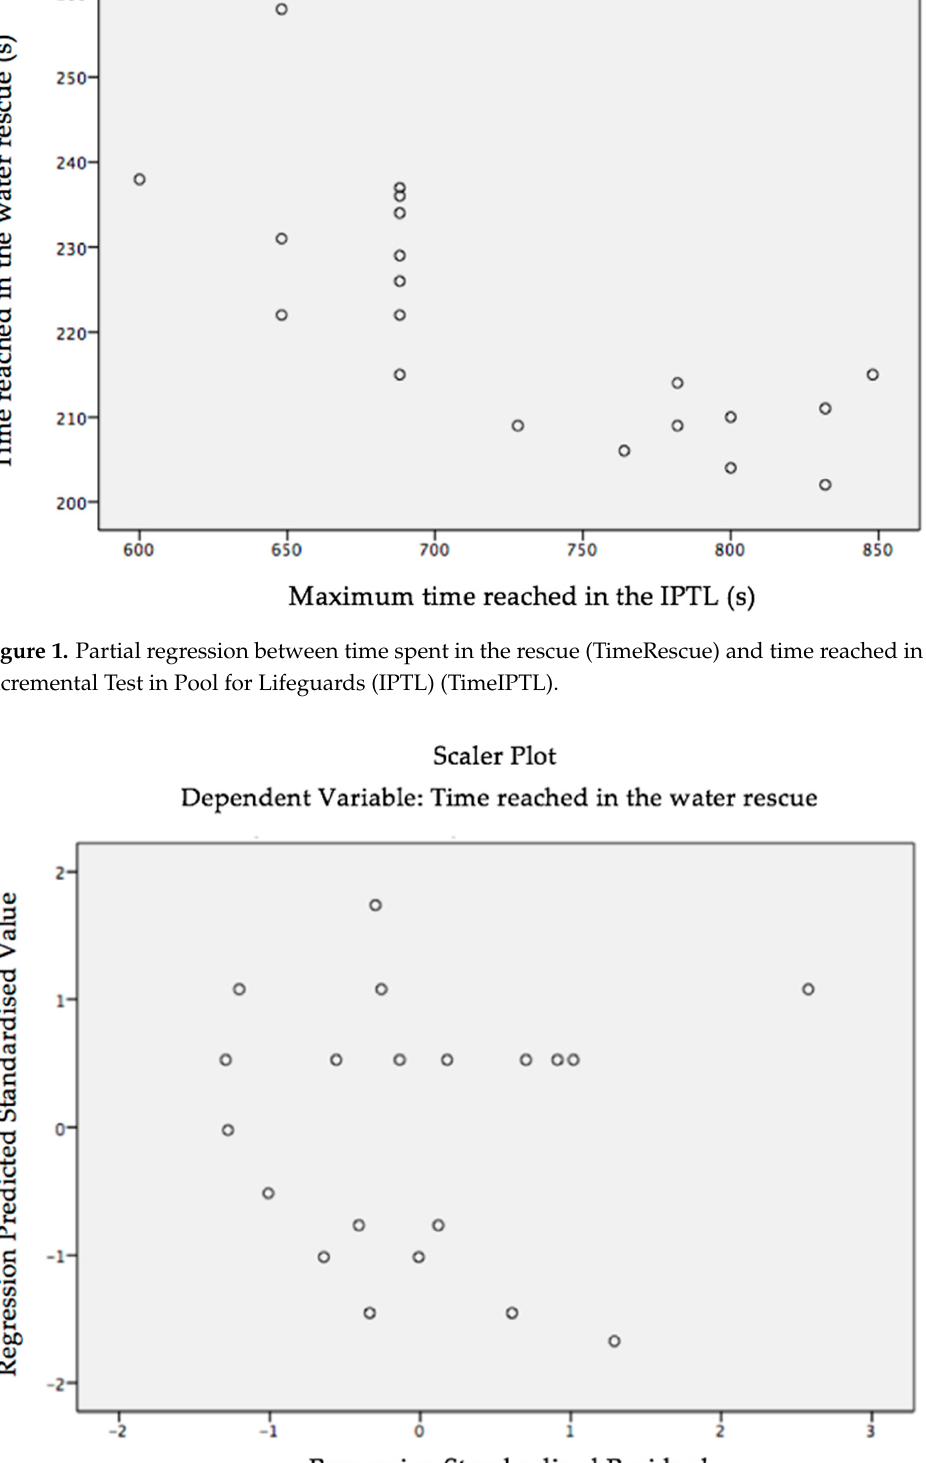
Figure 2. Predicted values according to the standardised residues for the dependent variable (Time Rescue